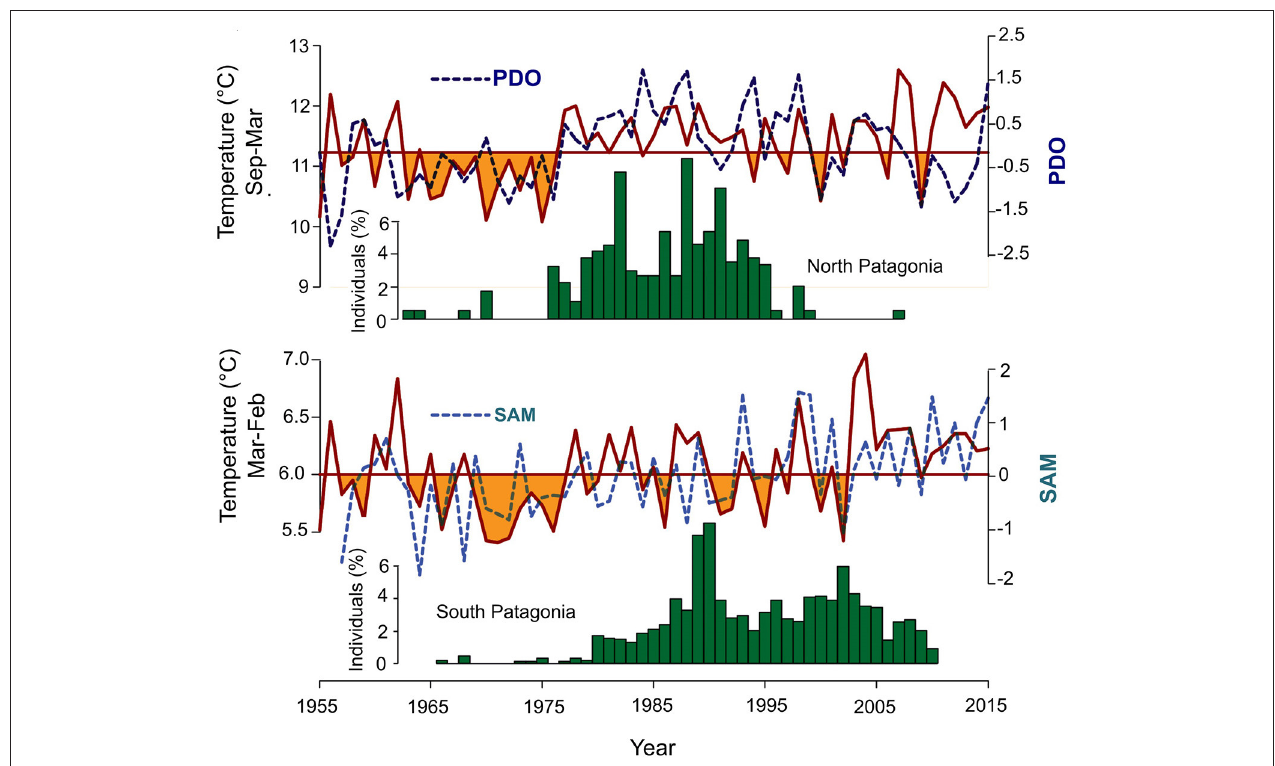
FIGURE 6 | Comparison between tree establishment above upper treelines in northern and southern Patagonia and their relationships with temperature and the associated atmospheric circulation indices. Temperature plotted with continuous line, PDO and SAM represented with dashed line.